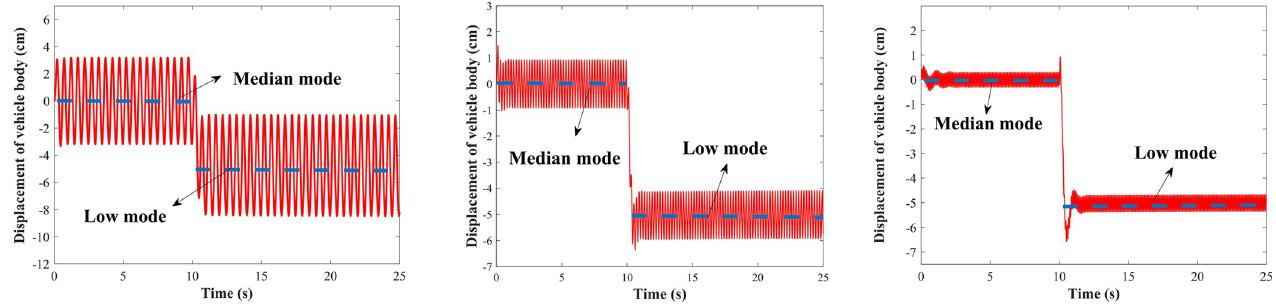
Fig 15. Median mode to low mode under the sinusoidal road. (A) f = 2 Hz; (B) f = 5 Hz; (C) f = 10 Hz.